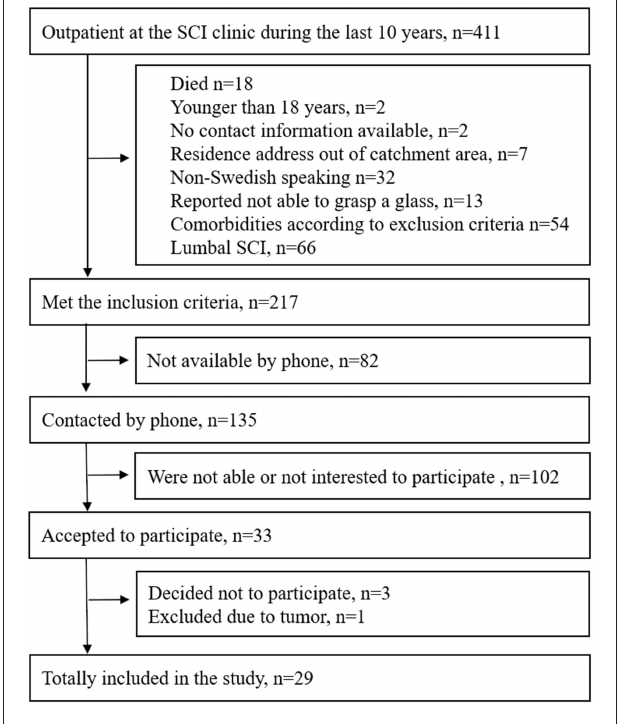
FIGURE 1 | Flow chart of inclusion process.